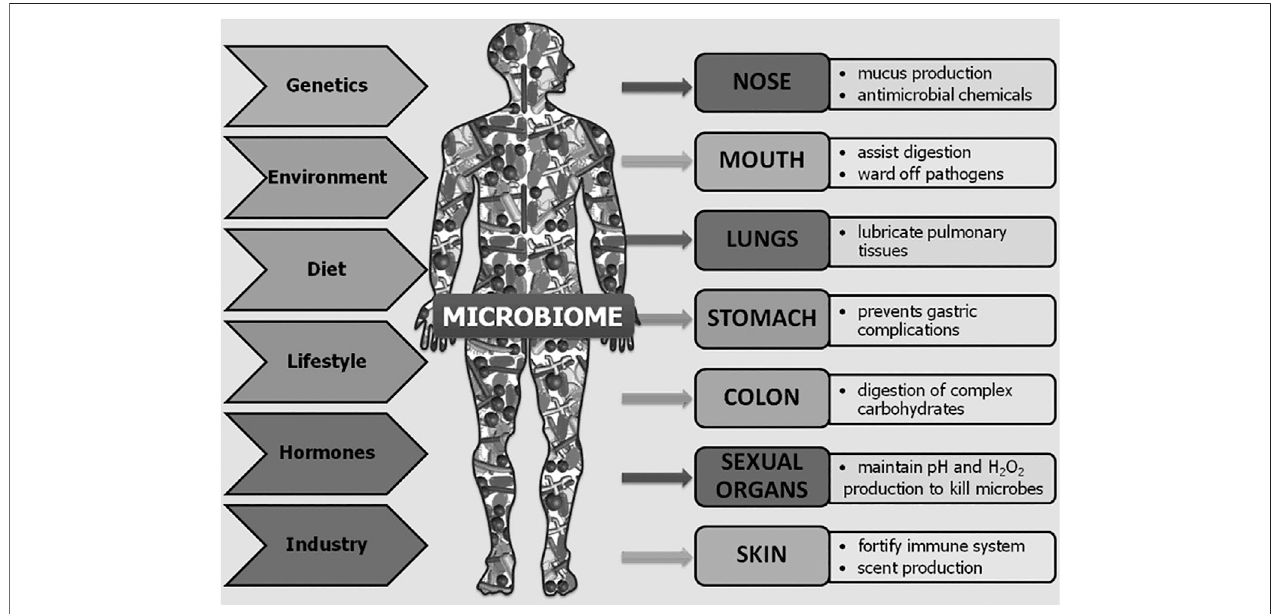
FIGURE 1 | Overview of the body areas inhabited by microbiota, their roles in those organs, and the factors contributing to their diversity among individuals and across time. Reprinted from Human Microbes — The Power Within , by V.D. Appanna, 2018. Springer Singapore (Appanna, 2018).